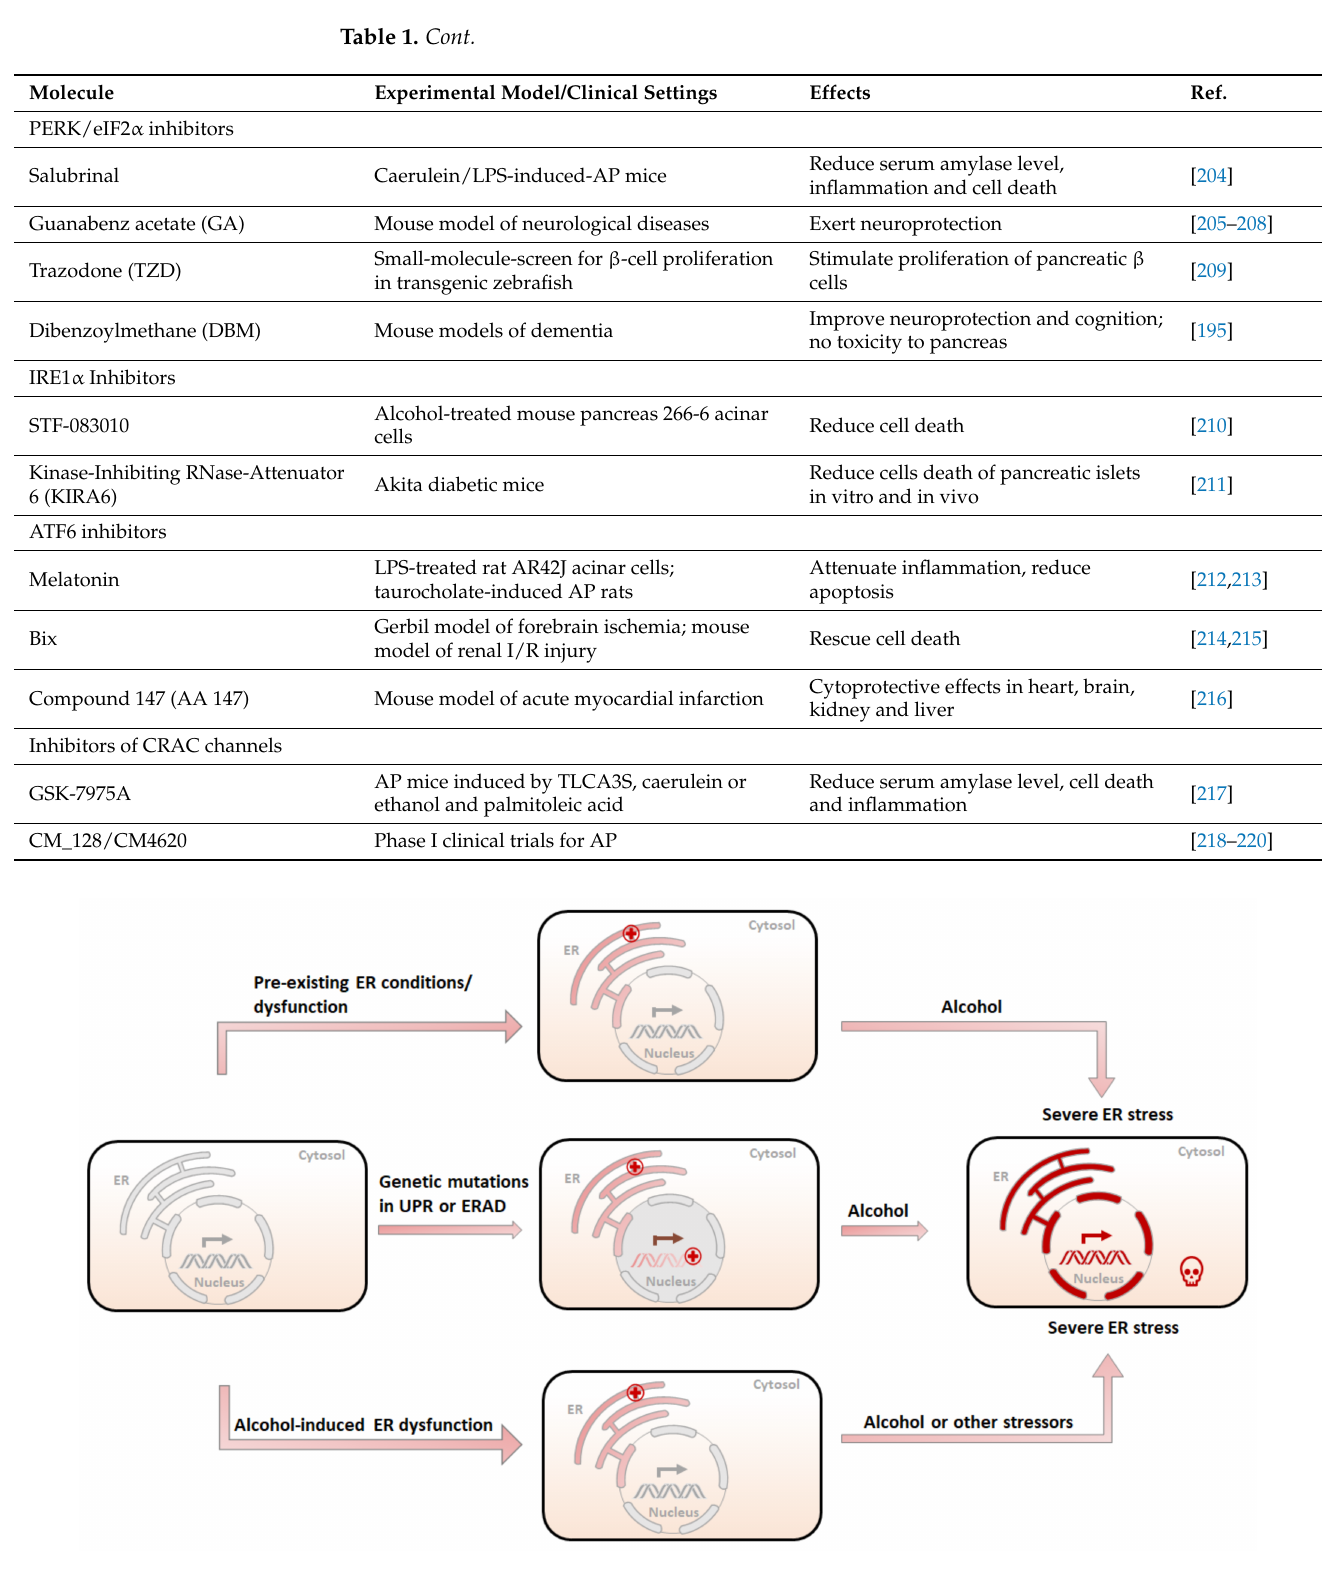
Figure 2. Possible etiology of alcohol-related pancreatitis. (1) A pre-existing ER condition resulting from stressors other than alcohol (tobacco, high-fat diet, etc.) is further exacerbated by alcohol exposure, causing irreversible damage to the ER and subsequent cell death. (2) Genetic mutations in UPR or ERAD compromise the ability of the ER to deal with unfolded/misfolded proteins,